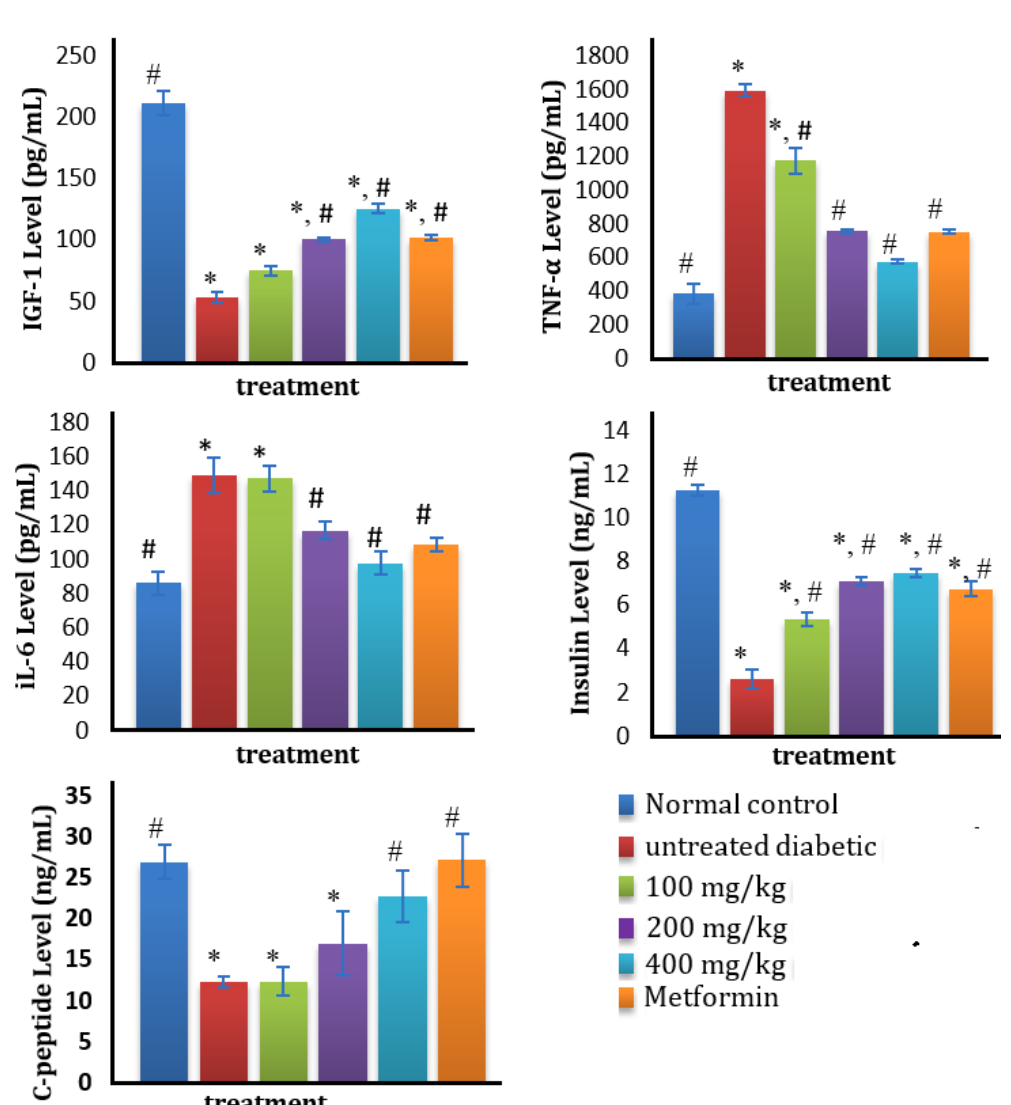
Figure 3 Effect of MPMTE on (a) IGF-1, (b) TNF-α, (c) IL-6, (d) insulin, and (e) C-peptide levels. Inflammatory biomarkers, insulin and C-peptide levels of normal rats and STZ-induced diabetic rats were measured at the end of the study. The values are mean ± SEM